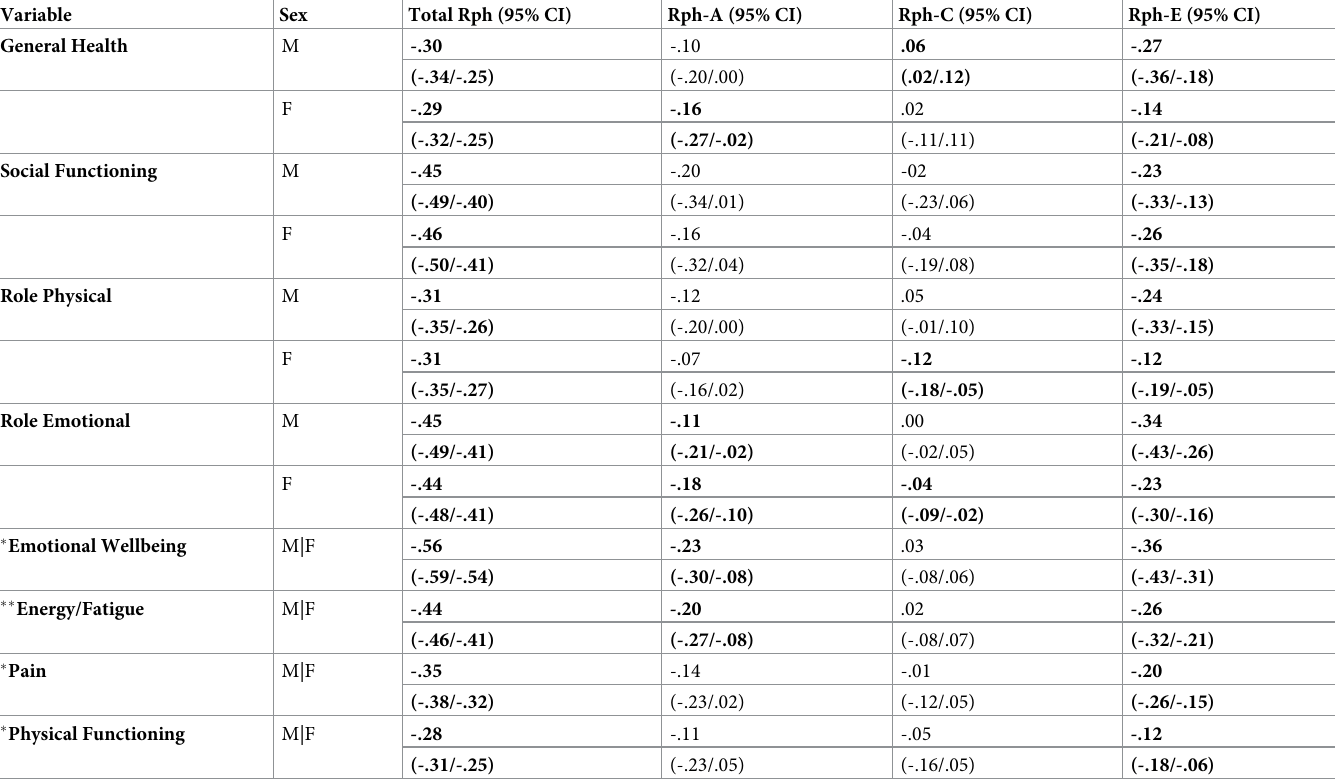
Table 5. ACE decomposition of the phenotypic correlations between SF-36 scales and depressive